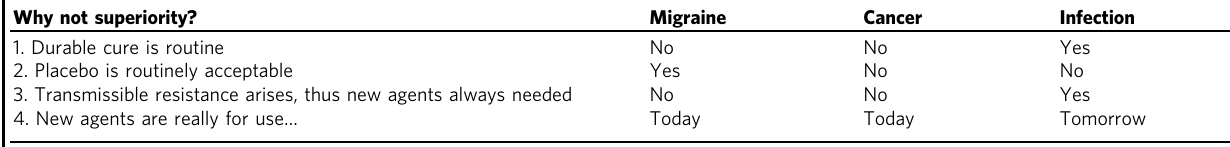
Table 4 Why superiority is pursued in some areas but not routinely available for anti-infectives Why not superiority?